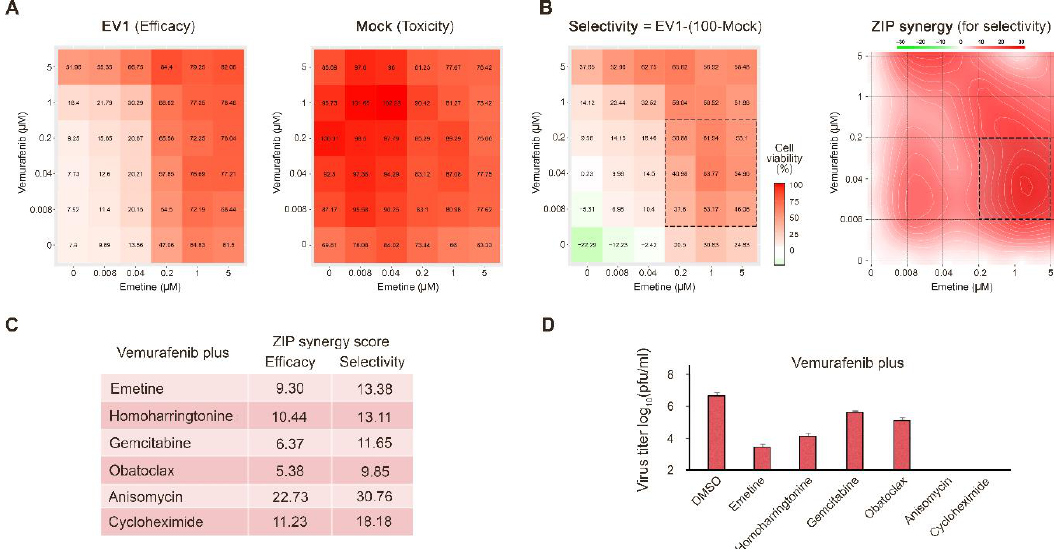
Figure 3. Combinations of vemurafenib with other antiviral agents rescue A549 cells from echovirus 1 (EV1)-mediated death and inhibit virus replication. ( A ) The interaction landscapes of one of the drug combinations measured using a CTG assay on EV1- and mock-infected cells. ( B ) The interaction landscape showing selectivity and synergy of the drug combination. ( C ) Synergy scores were calculated for efficacy (EV1-infected) and selectivity (EV1-infected–Mock) dose-response matrices for drug combinations. ( D ) The effects of 5 µM vemurafenib plus 0,1% DMSO, 0.2 µM emetine, 0.2 µM homoharringtonine, 0.2 µM obatoclax, 1 µL gemcitabine, 0,1 µL anisomycin and 1 µL cycloheximide on viral replication measured by plaque reduction assay.